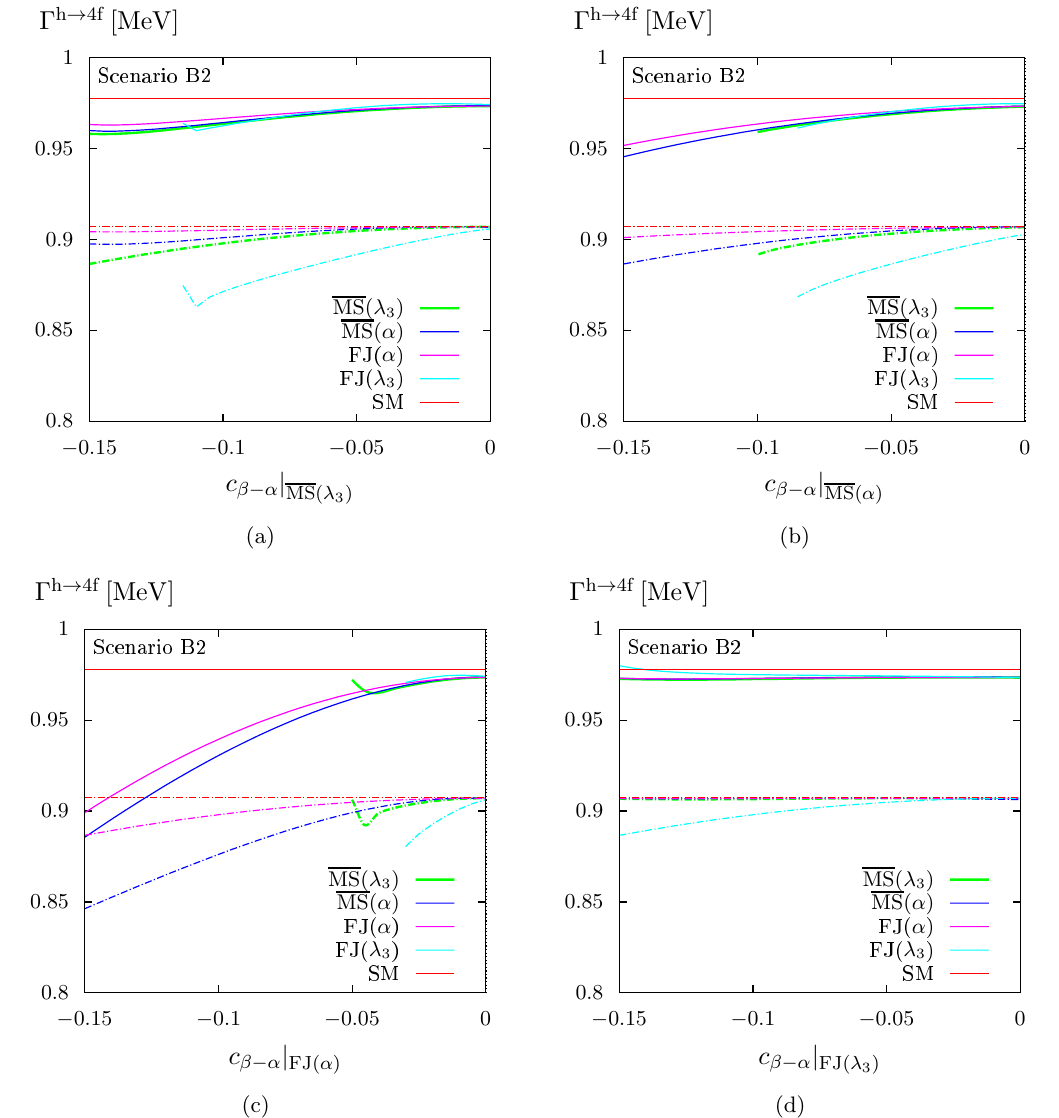
Figure 30 . The h 4 f width at LO (dashed) and NLO EW+QCD (solid) for scenario B2 in ! dependence of c (cid:12) (cid:0) (cid:11) . The panels (a), (b), (c), and (d) correspond to input values de(cid:12)ned in the MS( (cid:21) 3 ), MS( (cid:11) ), FJ( (cid:11) ), and FJ( (cid:21) 3 ) schemes, respectively. The input values are converted to the desired target scheme (colour code of (cid:12)gure 9) in which the calculation is performed. The SM prediction is shown for comparison in